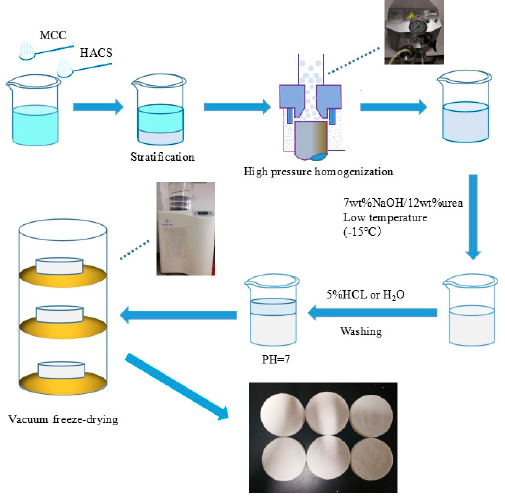
Figure 1. Hydrogel and aerogel preparation process.